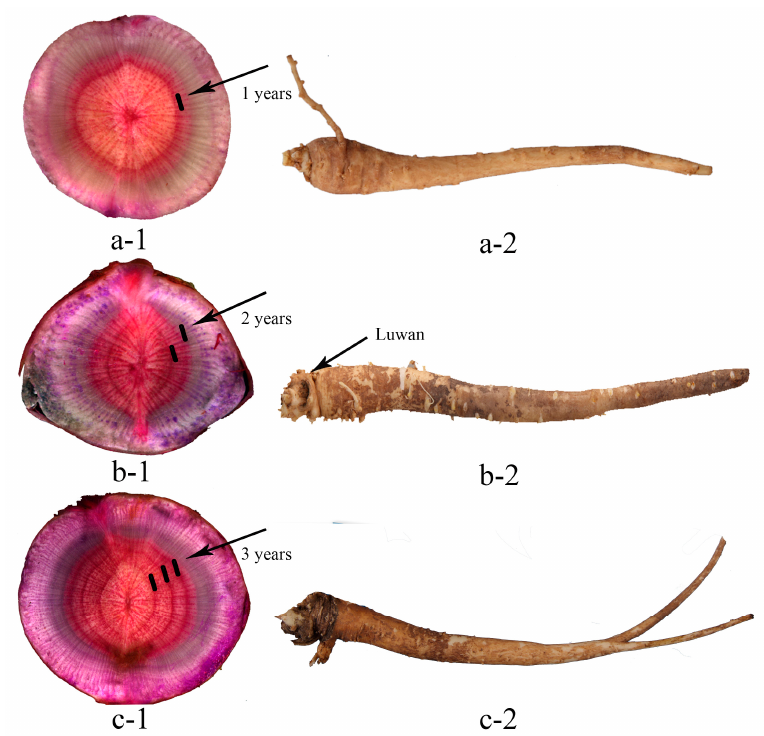
Figure 6. The determination of growth years of PR samples (1. transverse section of root; 2. root; a. one-year root; b. two-years root; c. three-years root.).